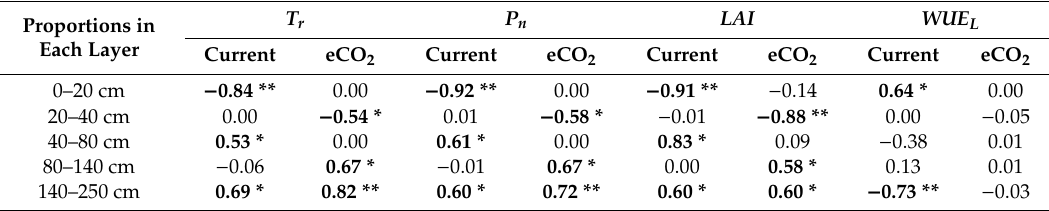
Table 2. Correlation analysis between proportions of soil water contribution in di ff erent layers and ecophysiological indices of maize during the seedling to filling growth period under current and eCO 2 treatments. T r P n LAI WUE L Proportions in Each Layer Current eCO 2 Current eCO 2 Current eCO 2